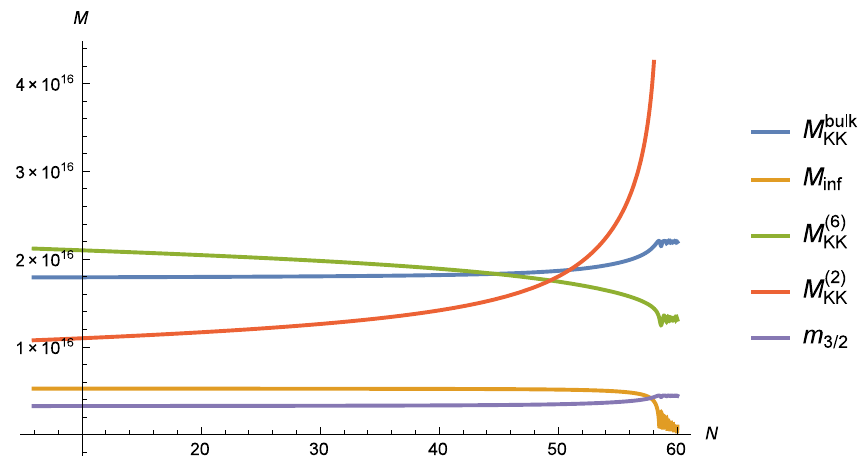
= M (2) ), the inflationary scale M inf = V 1 / 4 KK KK